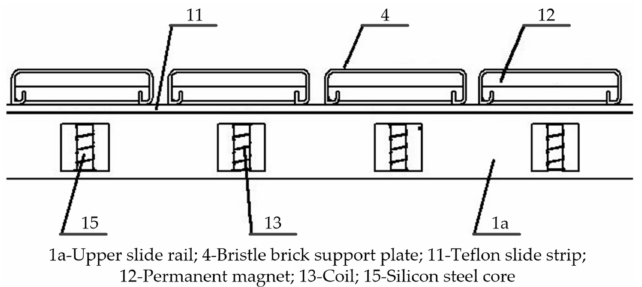
Figure 11. Adaptive modification of components of delivery system.